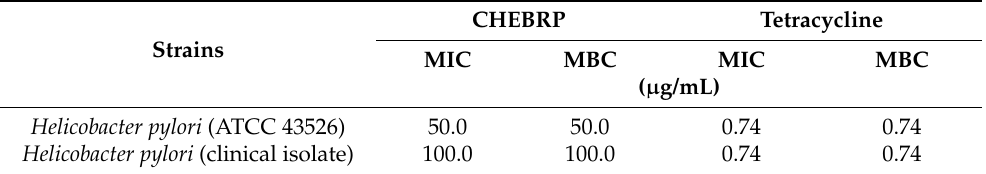
Table 1. Determination of Minimal Inhibitory and Bactericidal Concentrations of the crude hydroalcoholic extract of Brazilian red propolis against Helicobacter pylori strains (ATCC 43526 and clinical isolate). CHEBRP Tetracycline Strains MIC MBC MIC MBC ( µ g/mL) Helicobacter pylori (ATCC 43526) 50.0 50.0 0.74 0.74 100.0 100.0 0.74 0.74